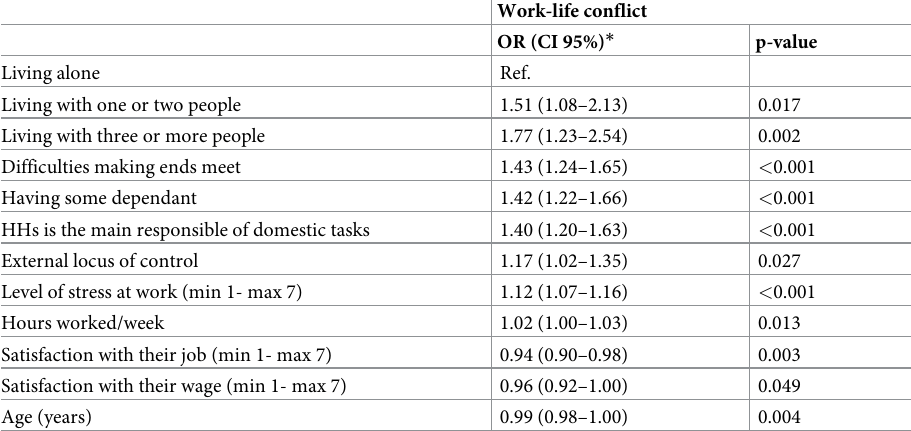
Table 5. Results of ordered probit models predicting work-family